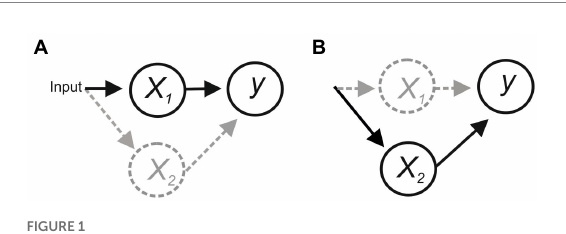
FIGURE 1 (A) Activation of x 1 is necessary and sufficient for activating y . But if an alternative pathway allowed x 2 to activate y then x 1 would be sufficient but not necessary (B)